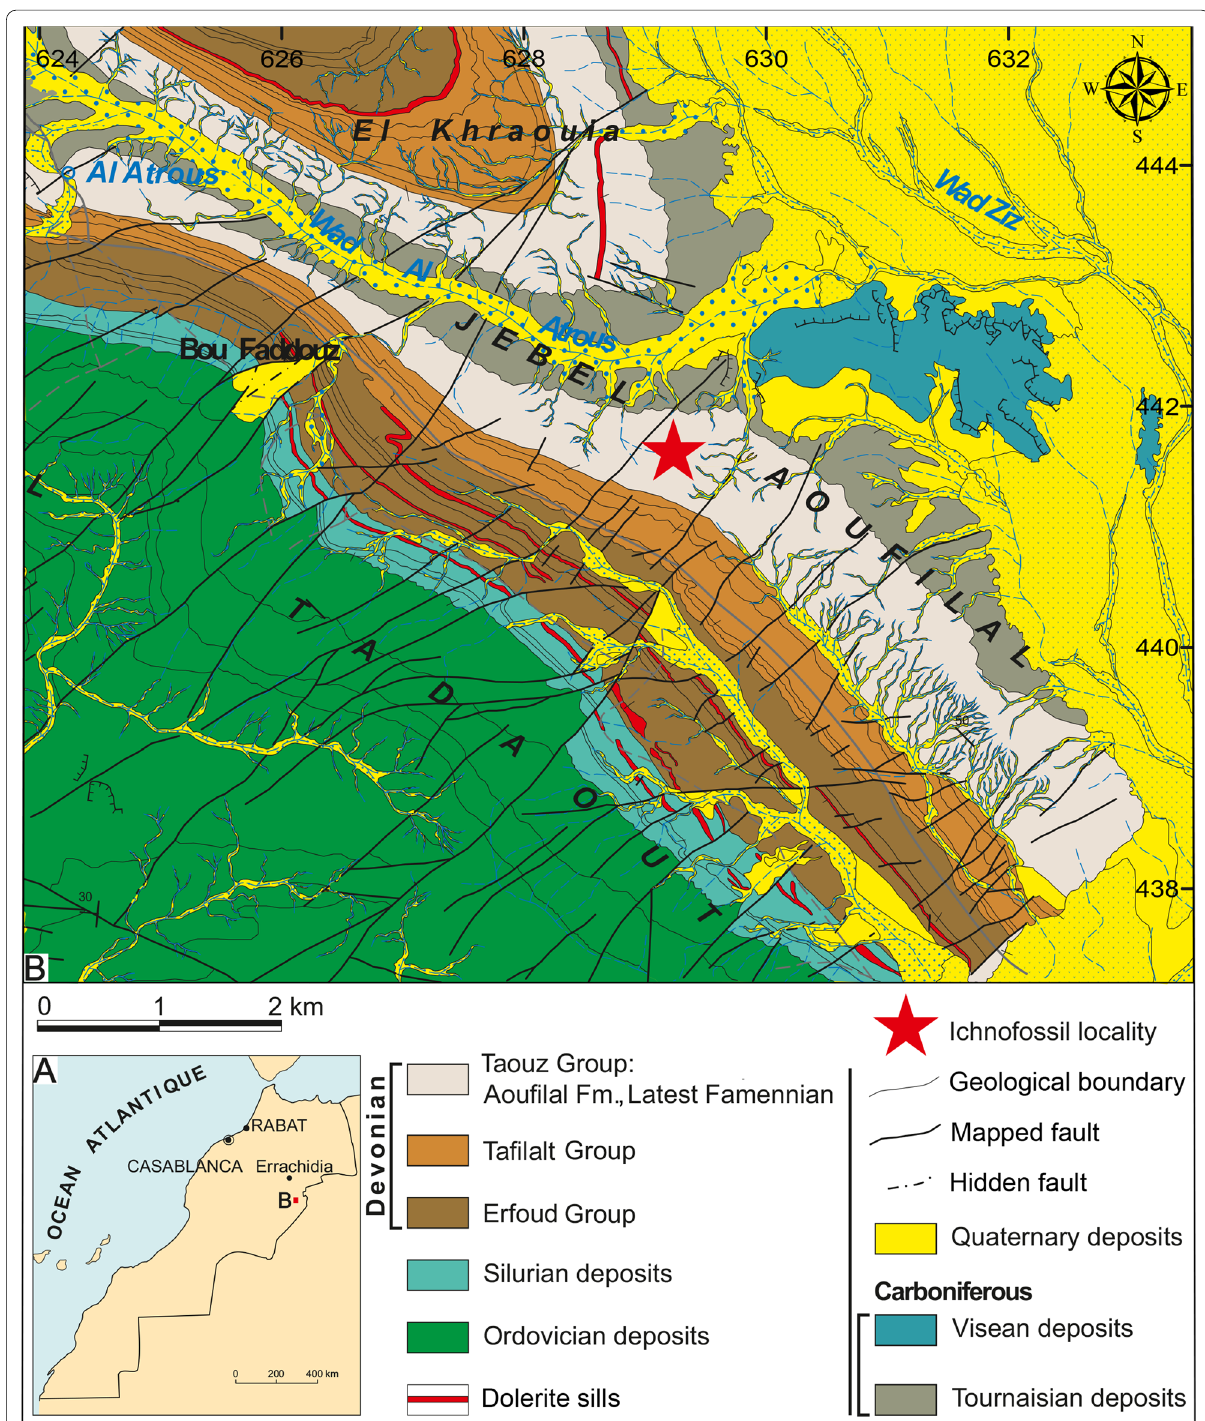
Fig. 1 A Location map of the study area. B Geological map of Al Atrous region showing the trace-fossil locality (map extracted from Alvaro et al.